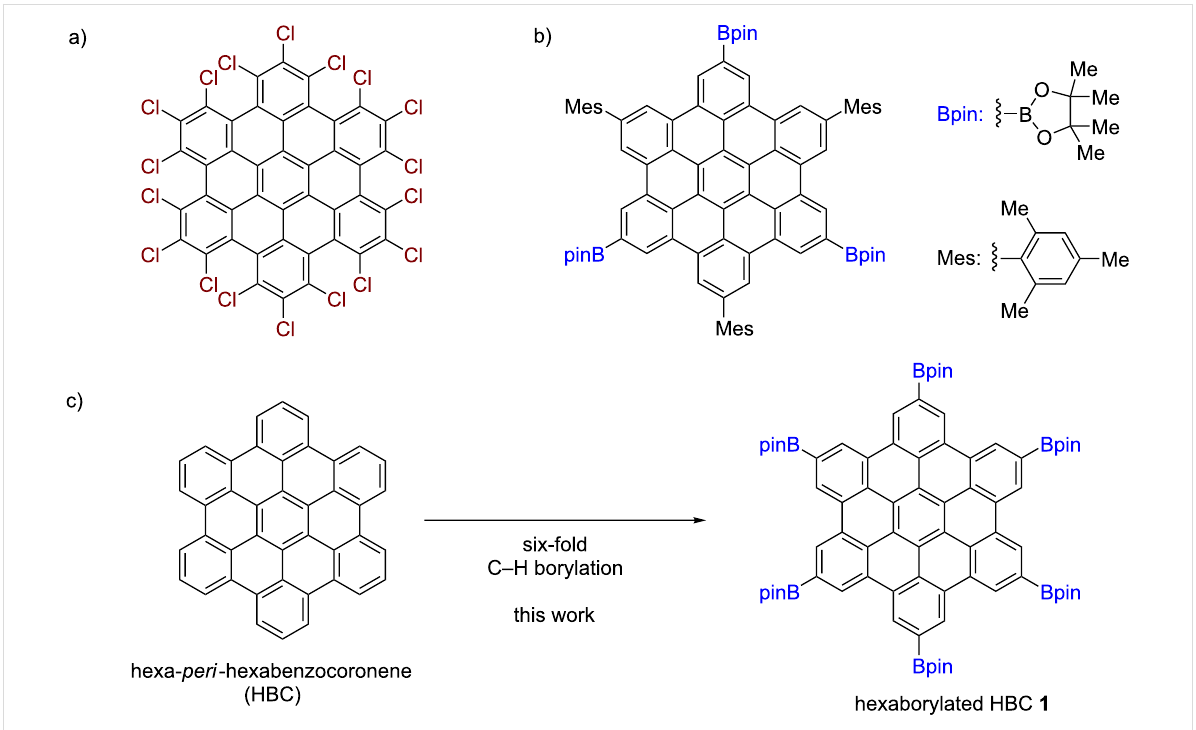
Figure 1: C–H functionalization of HBCs. (a) Perchlorinated HBC. (b) Borylated HBC substituted by 2,4,6-trimethylphenyl (Mes) groups. (c) Six-fold C–H borylation of HBC (this work).